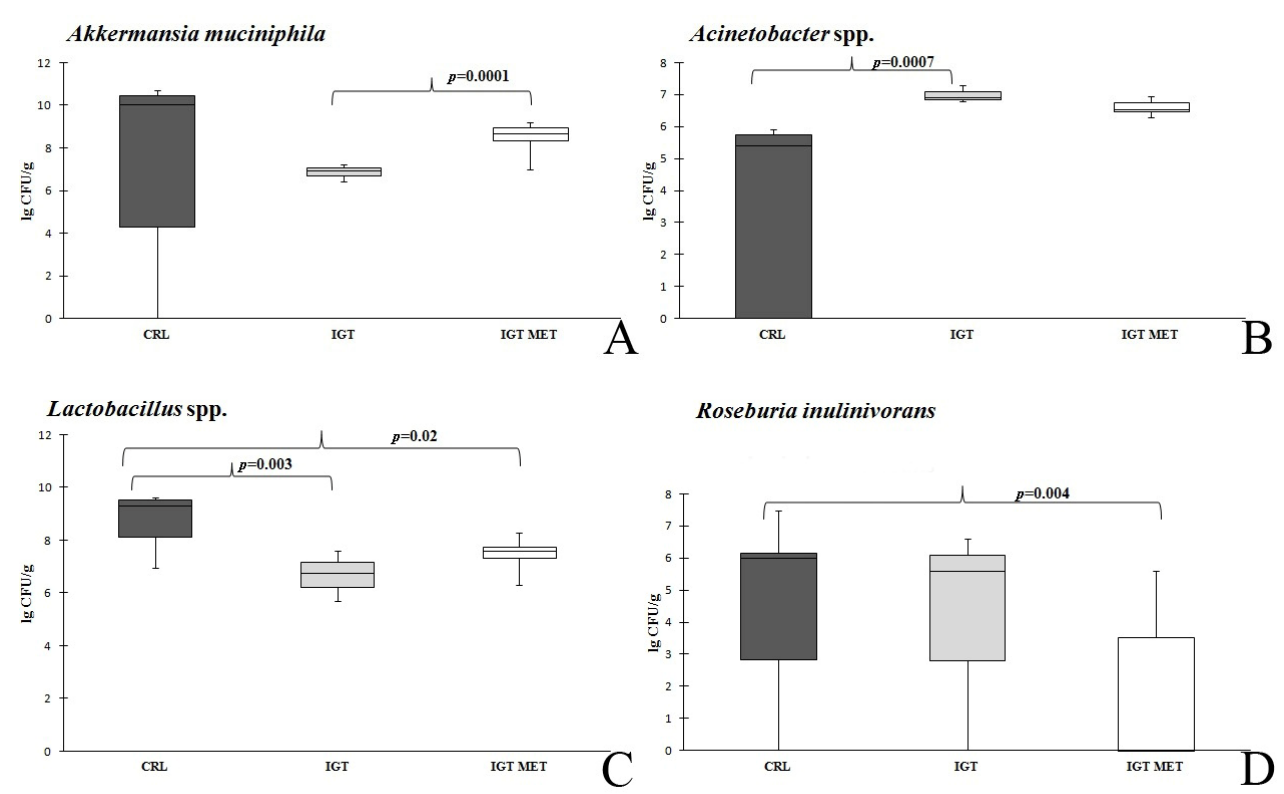
Figure 6. Akkermansia muciniphila ( A ), Acinetobacter spp. ( B ), Lactobacillus spp. ( C ) and Roseburia unulinivorans ( D ) quantitative content in the fecal samples of rats from different groups. Notes: Results are presented as median (25%; 75%). CRL—control group, IGT—impaired glucose tolerance group, IGT MET—impaired glucose tolerance + metformin group.